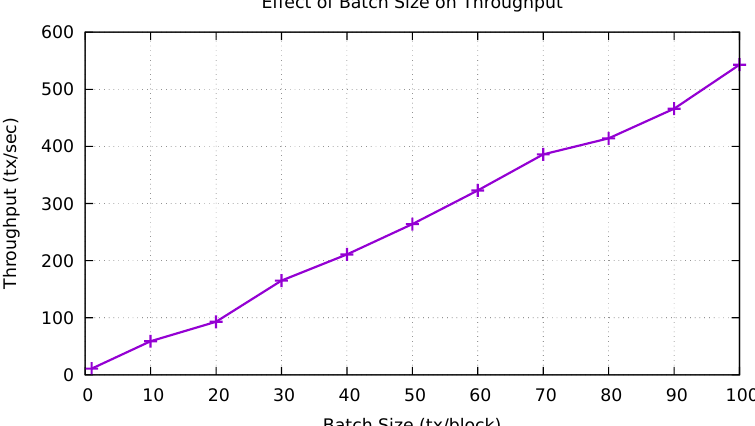
Figure 5. Effect of batch size on